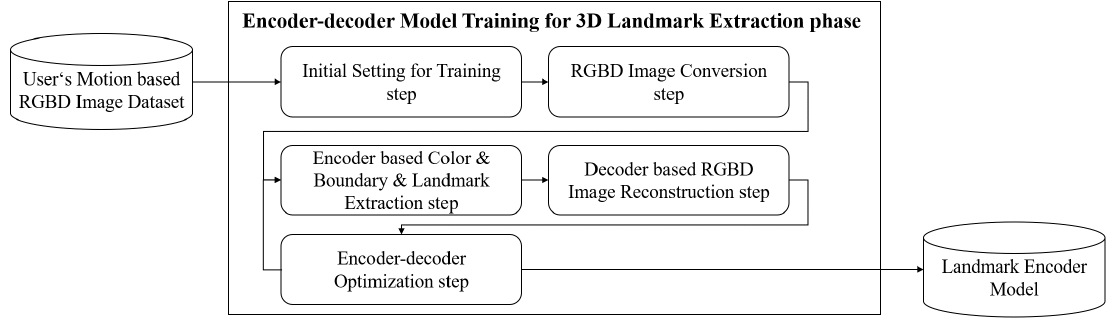
Figure 4. Encoder–decoder model training process using RGBD image.